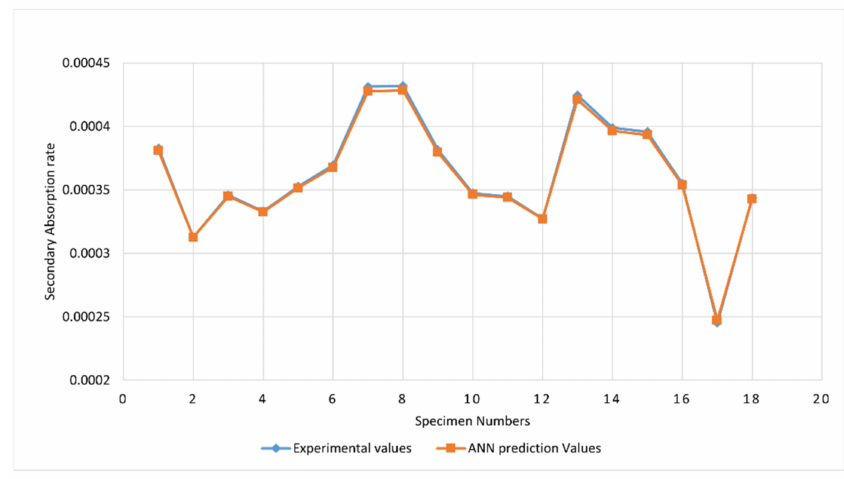
Figure 20. ANN vs. experimental—secondary absorption rate of test specimens.